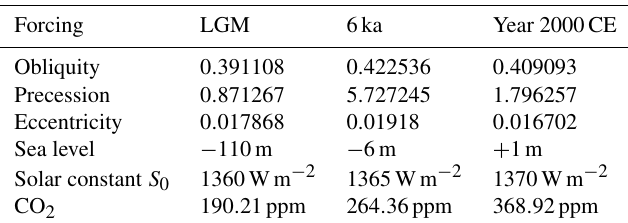
Table 8. Step forcings for the sensitivity test. Modeled states are associated with the LGM, the mid-Holocene warm period 6000BP, and 2000CE. Orbital parameters follow Laskar et al. (2004), sea level w.r.t. 0BP is from Grant et al. (2012), and CO 2 is from Köhler et al. (2017). Appendix A shows the land, sea, and ice distributions corresponding to the sea levels of the three modeled periods. The solar constant is chosen such that it, like the other forcings, changes significantly.